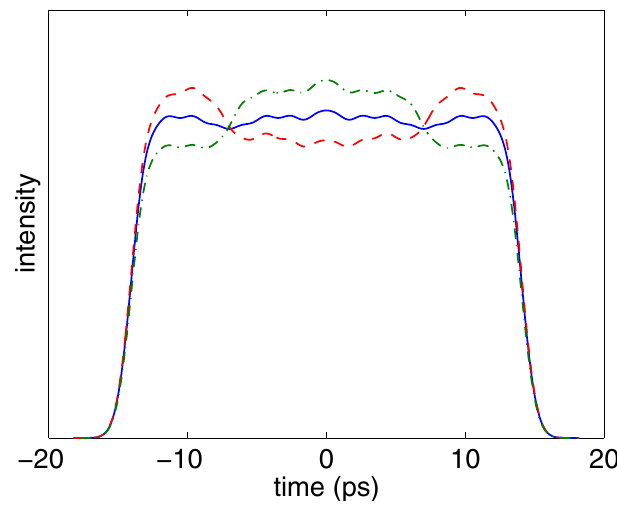
FIG. 4. (Color) Calculated temporal shape for given crystal lengths and materials. Orientations of the optical axis of each of the four crystals with respect to the incident laser polarization direction (0 (cid:6) ) are as following: 45 (cid:6) , 0 (cid:6) , 45 (cid:6) , (cid:4) 0 : 7 (cid:6) (solid); 45 (cid:6) , 2 (cid:6) , 47.4 (cid:6) , 1.5 (cid:6) (dashed); 45 (cid:6) , (cid:4) 2 : 4 (cid:6) , 42.6 (cid:6) , (cid:4) 2 : 9 (cid:6) (dot-dashed line).